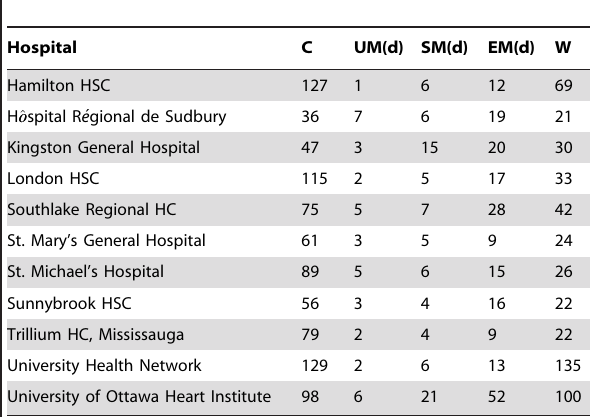
Table 1. Cardiac Care Network of Ontario cardiac surgery statistics (January 2008–March 2008).